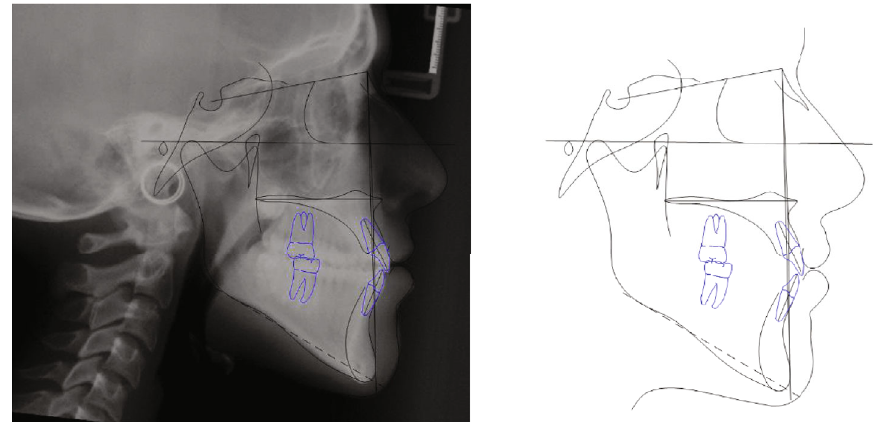
Figure 15: Case no. 2 tracings at T